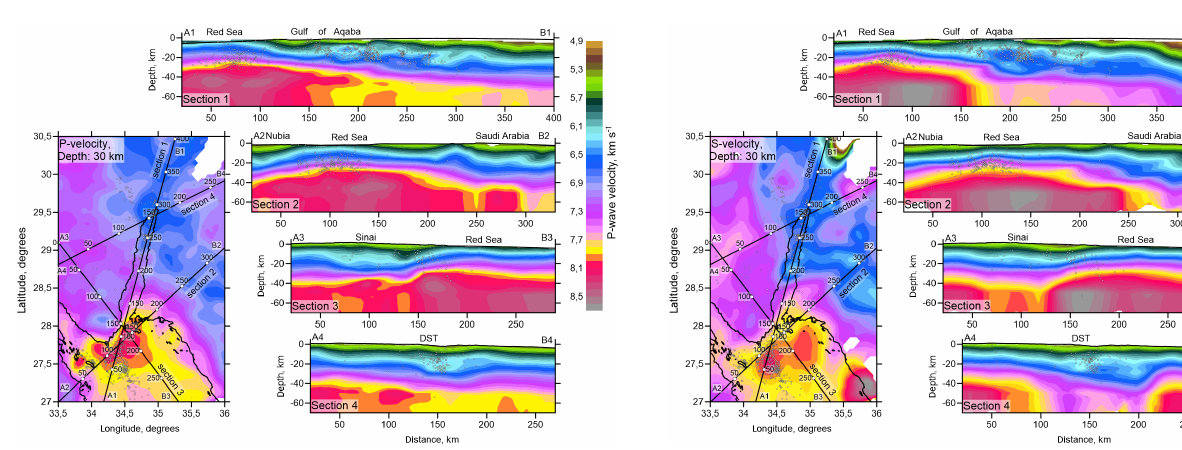
Figure 8. Absolute P velocity at 30km depth and in four vertical sections. Locations of the sections are shown in the map. White dots are the projections of earthquakes onto the profiles.